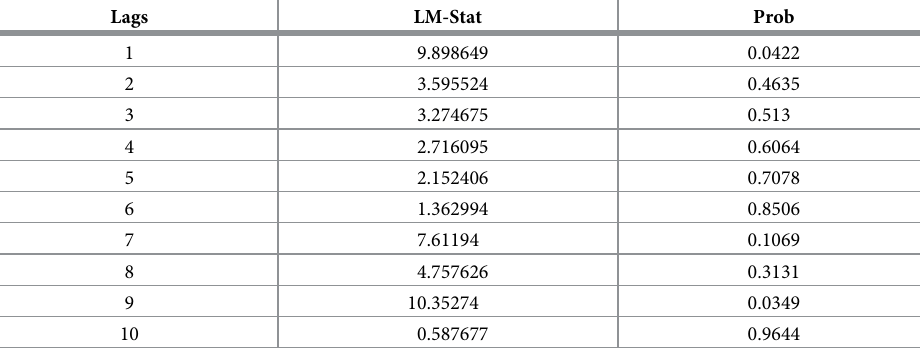
Table 15. Serial correlation LM test for Korean data when P = 1 (Fisherian model).